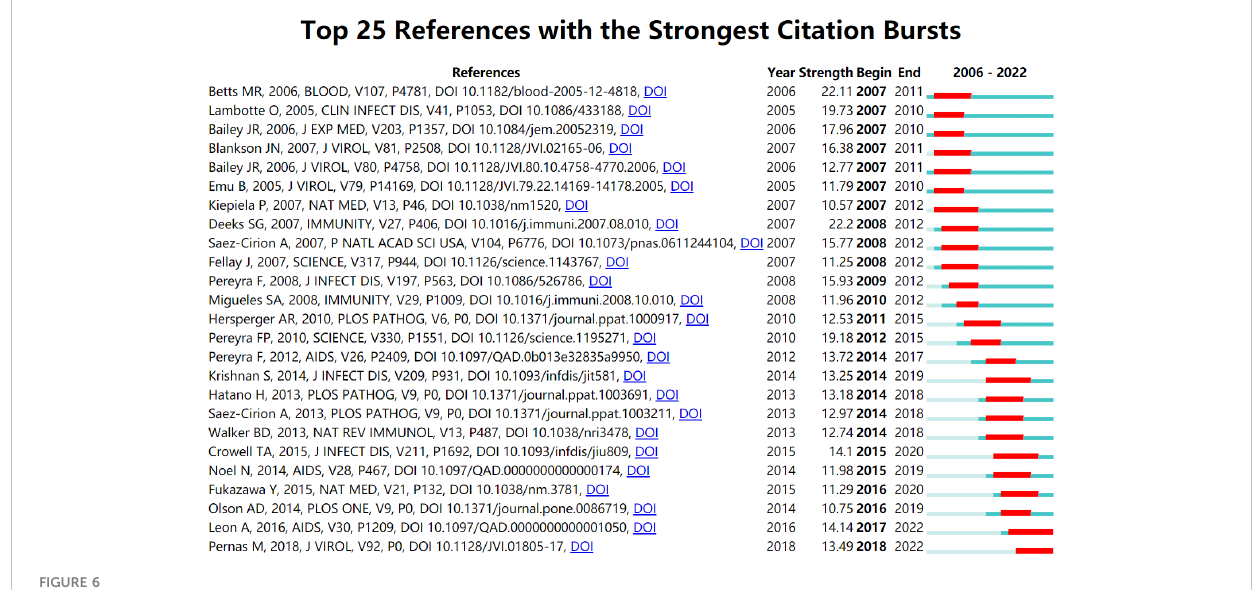
FIGURE 6 Top 25 references with the highest cocitation burst values of the 857 references on elite controller research. The red line corresponds to the period of surge in